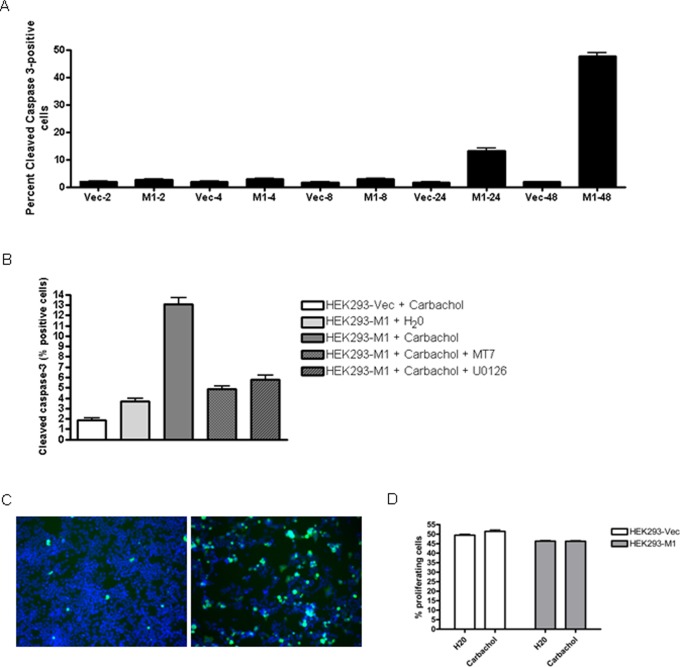
M1 mAChR activation induces cleaved-caspase 3 but does not induce changes in proliferation.HEK293-M1 and HEK293-Vec cells were stimulated across a 48 hour time course (2, 4, 8, 24, and 48 hours) with 100 µM carbachol (A). Induction of cleaved caspase-3 was evident following carbachol but only in the HEK293-M1 (M1) expressing cells. The induction was statistically significant at 24 hours and by 48 hours almost 50% of the cells expressed cleaved caspase 3. In contrast, there was no expression of cleaved caspase 3 in HEK-Vector (Vec) expressing cells. (B. To determine whether this expression was M1-mediated and MEK-mediated HEK293-M1 cells were incubated with the M1 antagonist MT7 or the MEK blocker U0126 and then challenged with carbachol. Induction of cleaved caspase 3 by carbachol was strongly inhibited by both drugs indicating that it was M1- and MEK-mediated. C. Photomicrographs of cleaved caspase 3 in HEK293-M1 cells 48 hours after vehicle (left image) or carbachol (right image) addition showing strong induction of cleaved caspase 3 in carbachol treated cells. (D) HEK293-Vec cells and HEK293-M1 cells were stimulated with 100 µM carbachol or vehicle for 24 hours, where BrdU was included during the final hour of treatment. BrdU incorporation revealed that the carbachol mediated reduction in cell numbers was not as a consequence of influencing proliferation. BrdU positive cells are as a percentage of the total cells counted to represent percentage proliferating cells. Data are representative of at least three independent experiments.